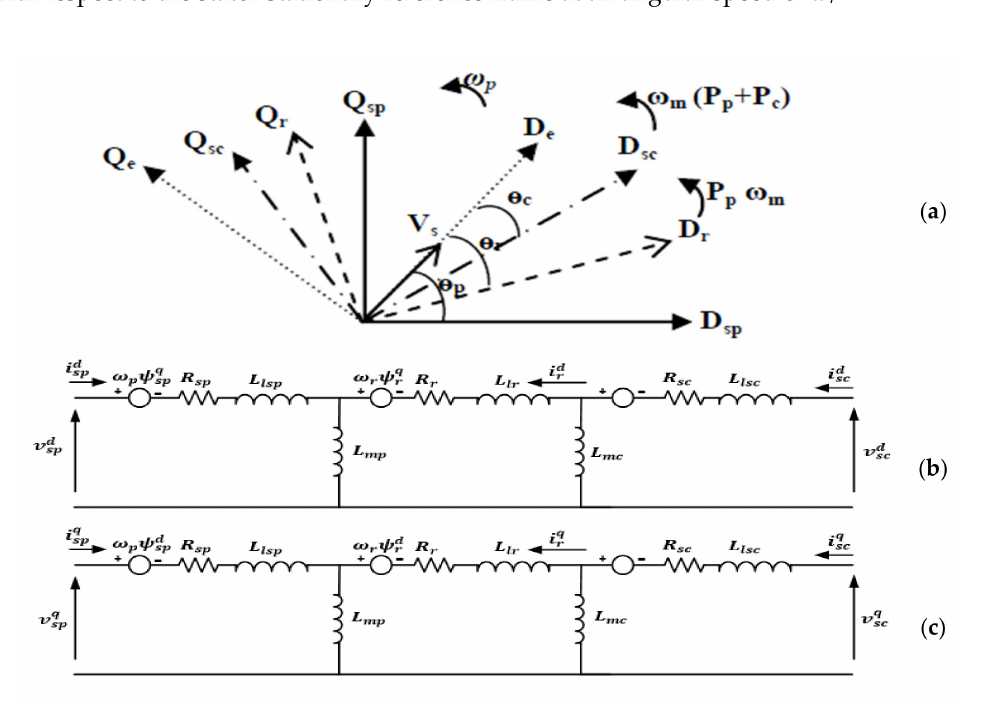
Figure 4. BDFTIG dynamic model: ( a ) d_q axis transformation, ( b ) equivalent d-axis Circuit, and ( c ) equivalent q-axis